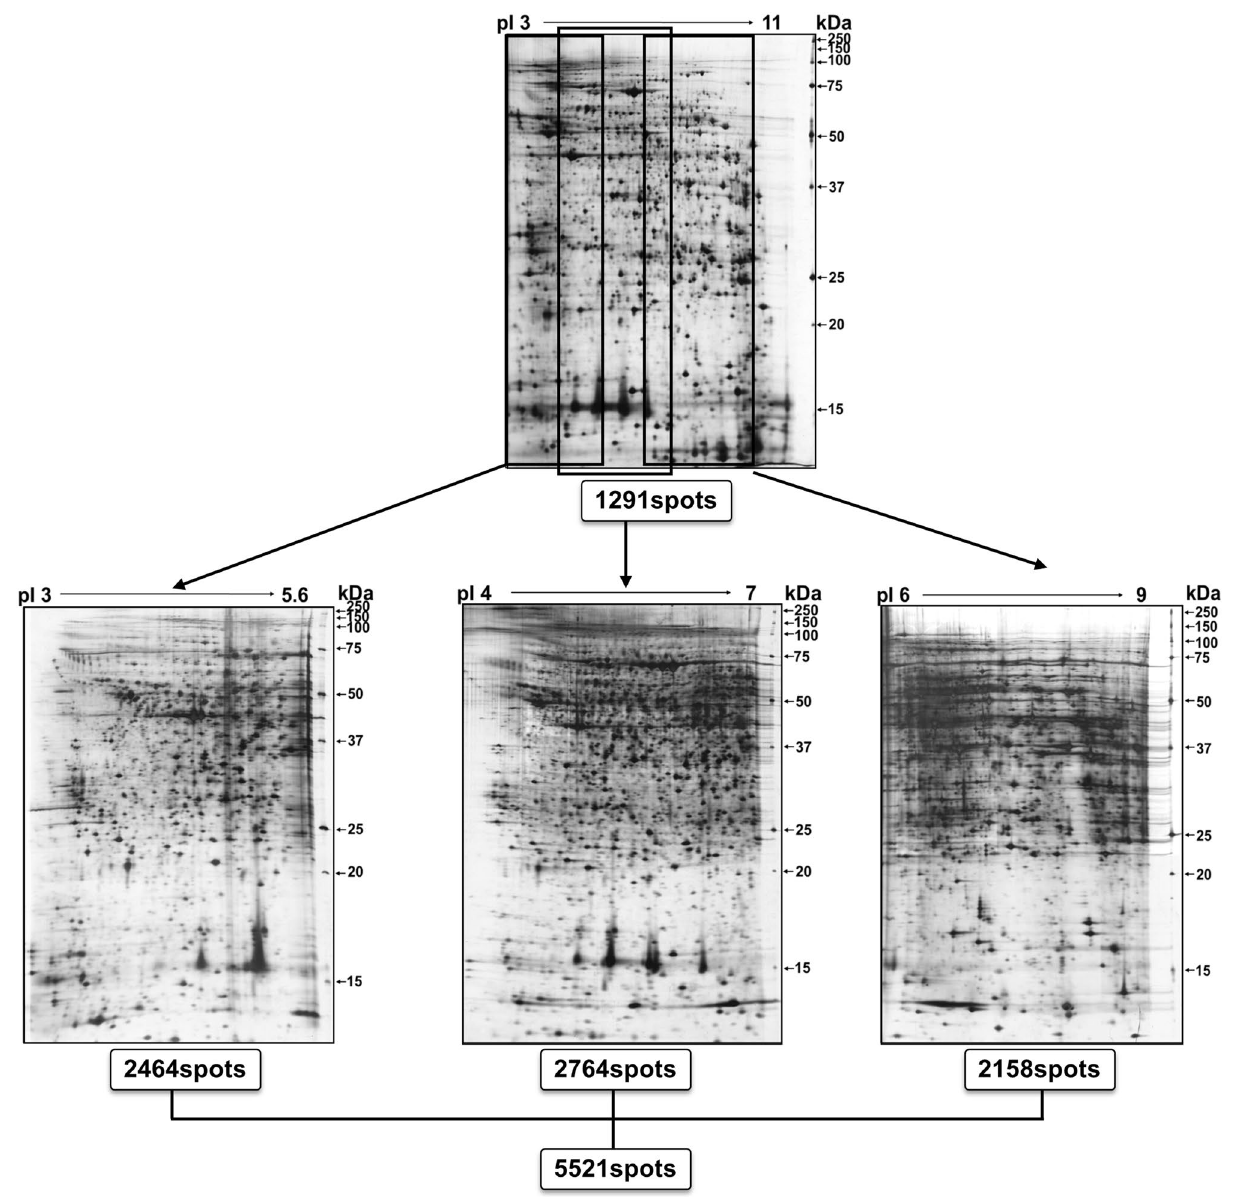
Figure 2. 2-DE analysis of total protein in rat kidney tissue. Analysis was performed using four different pI strip ranges (3–11, 3–5.6, 4–7, and 6–9). Proteins were profiled using large gels (35 cm × 45 cm) system and visualized by silver